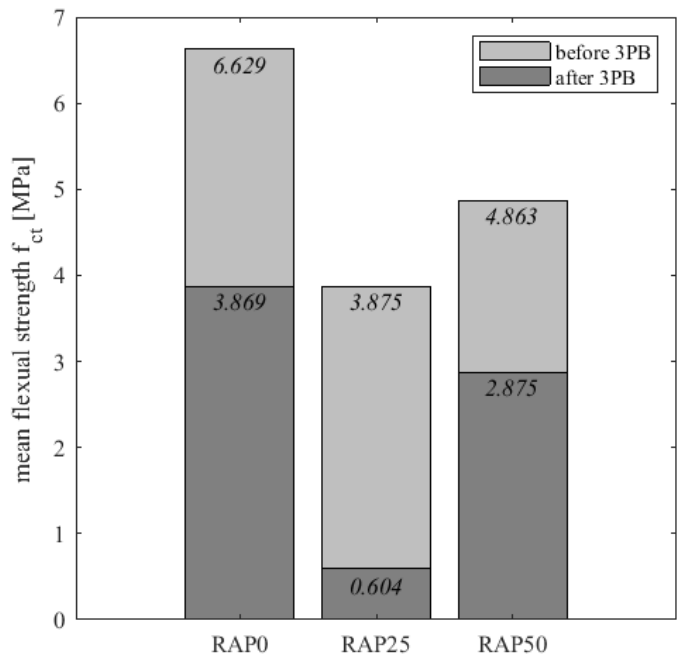
Figure 9. Flexural strength comparison before and after 3-point bending